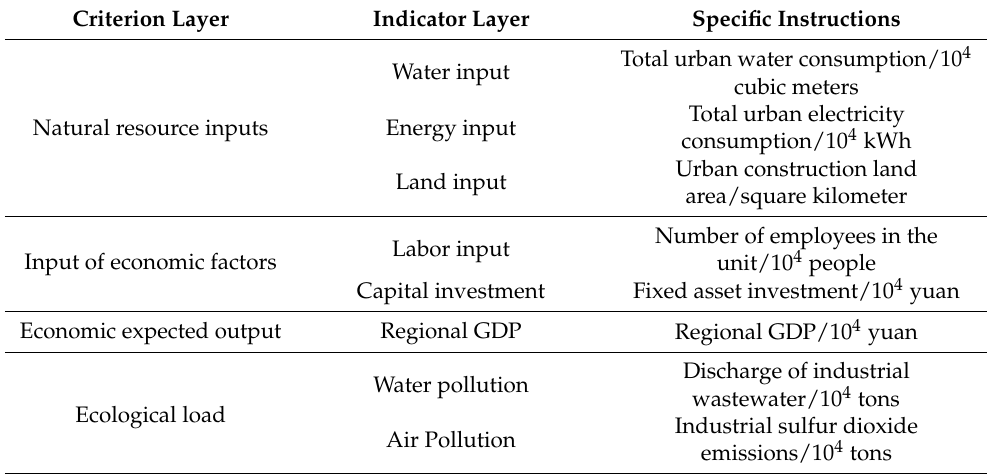
Table 1. Ecological efficiency input–output